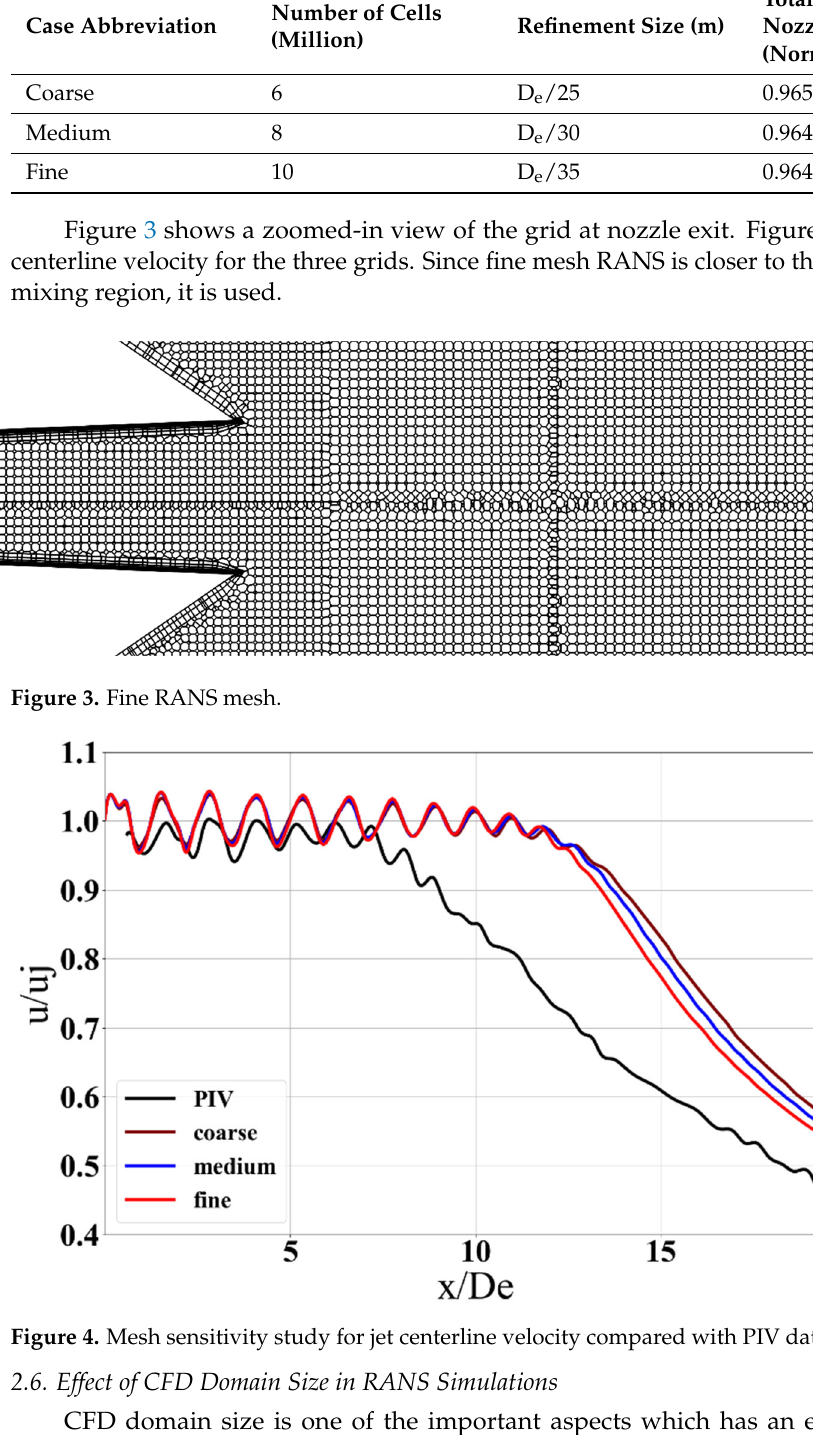
Table 2. Mesh sensitivity parameters for RANS simulations.